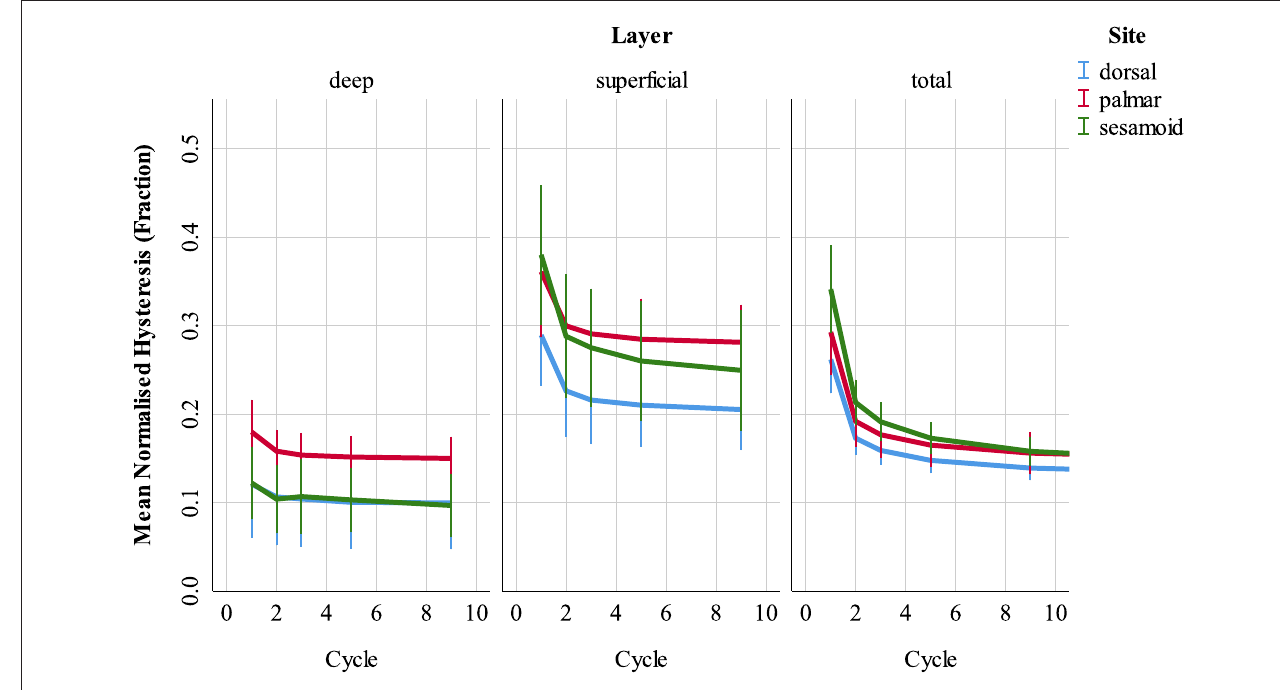
FIGURE 6 | Normalized hysteresis (fraction of energy loss) of cartilage-bone specimens over the first nine compressive loading cycles at three sites (dorsal MCIII, palmar MCIII and proximal sesamoid) within the metacarpophalangeal joint of n = 10 Thoroughbred racehorses. Layers of each specimen (superficial 2mm, deeper 2mm, and total ∼ 10mm thick cartilage-bone) are stratified into columns. Unadjusted means with 95% confidence intervals are displayed. Note that in the deep layer, dorsal (blue) hysteresis is obscured by sesamoid (green)